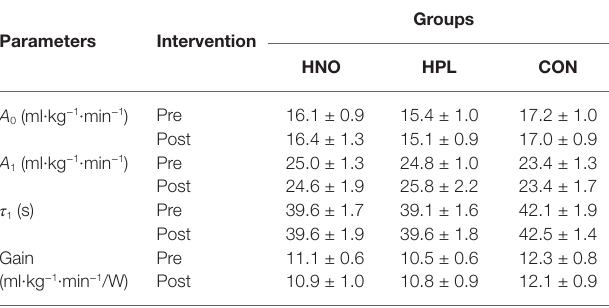
Table 2 shows the mean values for the oxygen saturation’ parameters obtained during the T lim test in both pre- and post-intervention periods. Except for SmO 2recovery (group main effect: p = 0.001, d = 0.4), which was significantly higher in hypoxia compared with normoxia ( p = 0.04, d = 0.82), no other